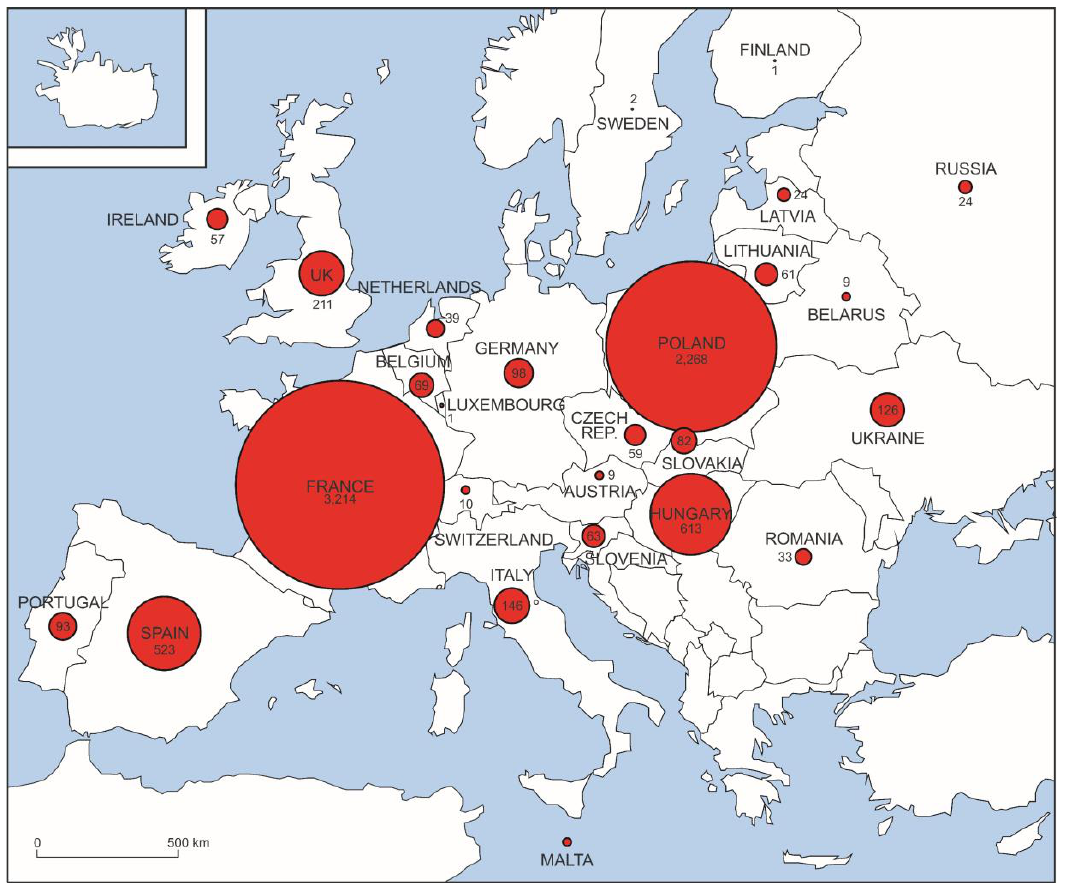
Figure 3. Origins of the European participants of the Days in the Dioceses in the Archdiocese of Lodz (Source: authors, based on the data provided by the